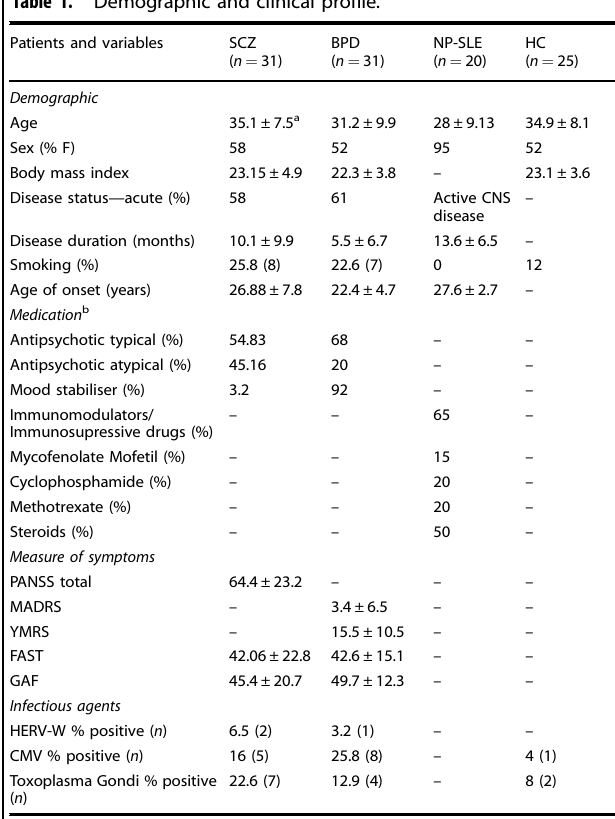
Table 1. Demographic and clinical pro fi le.